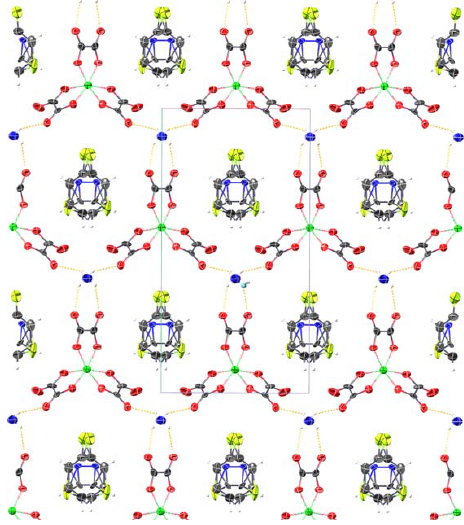
Figure 4. Projection of the anion layer along c axis showing the honeycomb packing arrangement of the tris(oxalato)ferrate anions for the salts 1 – 5, using salt 5 as an example. Thermal ellipsoids are of 50% probability.